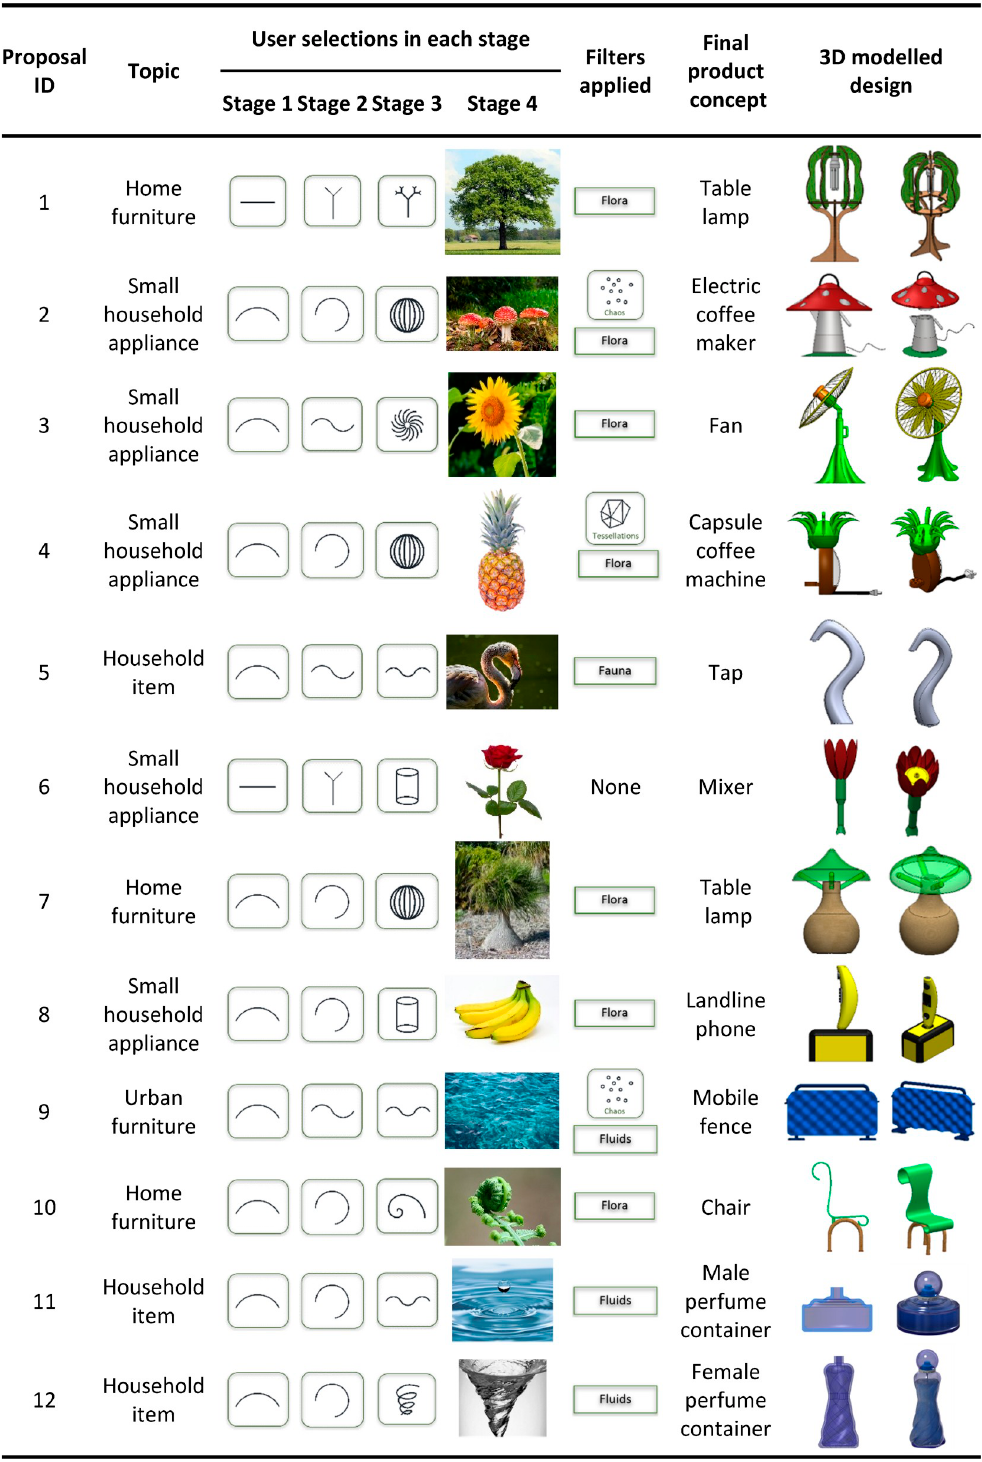
Fig 7. Detail of the finally selected designs during the evaluation process of the proposed paradigm.